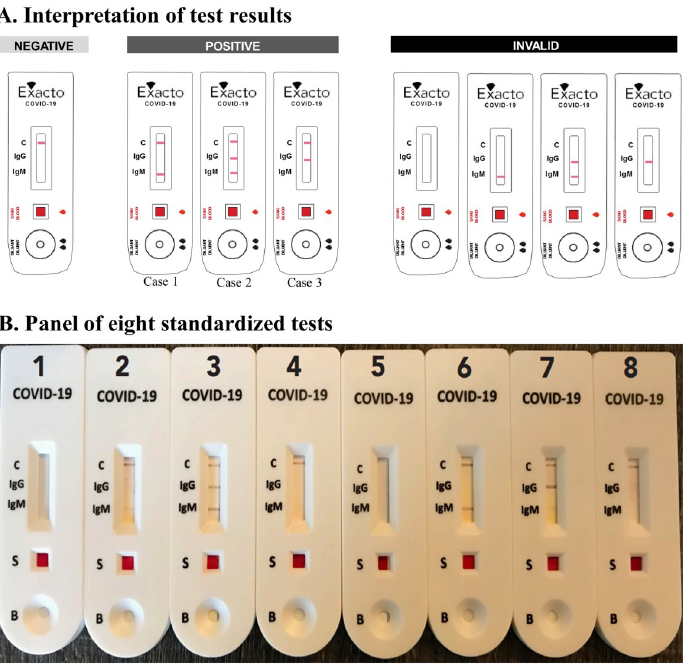
Fig 2. Interpretation of self-test results. A. The self-test result was interpreted as negative when a Control line (C) was present and readable and the “IgG” and “IgM” lines were absent. It was positive when a “C” and “IgM” (clearly or poorly readable) (case 1), or “C” and “IgG”, or “C”, “IgM” (clearly or poorly readable), and “IgG” lines were present. Finally, it was invalid when the “C” line was absent regardless of the presence or absence of the “IgG” and/or “IgM” line. B. Panel of 8 Exacto 1 COVID-19 self-test (Biosynex Swiss SA) cassettes, including 4 positive tests (#2, #3, #6 and #7), 2 negative tests (#4 and #8) and 2 invalid tests (#1 and #5). The #2 and #37 are weakly positive for IgM. Each volunteer randomly drew 4 tests among a panel of 8 and interpreted them with the help of the reading and interpretation scale. The observer noted the number of the drawn test and the result given by the